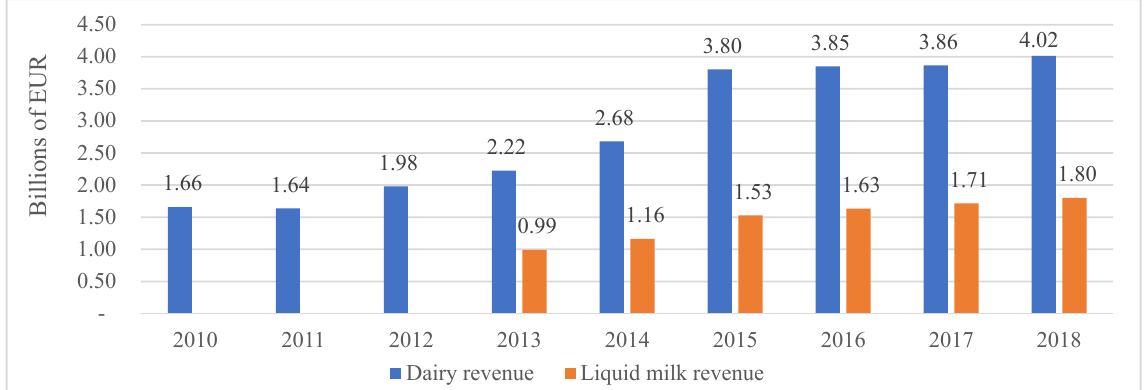
Figure 4. The revenues of the total dairy market and liquid milk market (billions of EUR). Source: Authors’ analysis based on GSO [36].